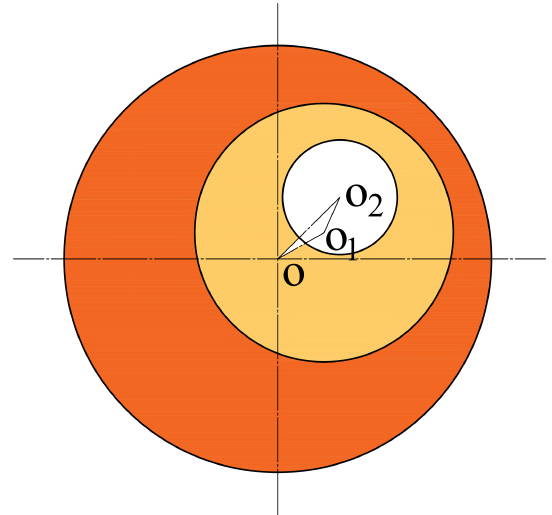
Figure 1. Structure of rotary forging machine with two eccentricity rings Figure 2. Position relationship of internal and external eccentric